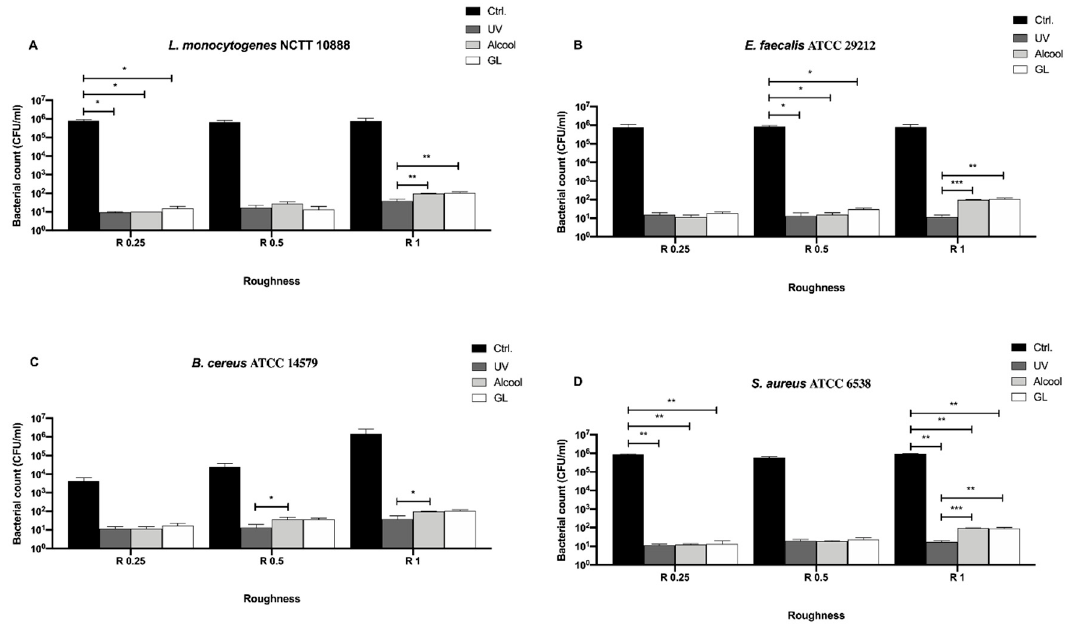
Figure 5. Antibacterial activity of UV, alcohol and GL against Gram ‐ positive bacteria ( A ) L. monocytogenes NCTT 10888, ( B ) E. faecalis ATCC 29212, ( C ) B. cereus ATCC 14579 and ( D ) S. aureus ATCC 6538 at different surface roughness, *** p < 0.001, ** p < 0.01, * p < 0.05.